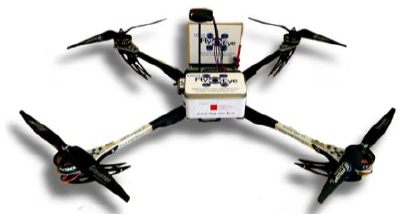
Figure 4: Built UAV -